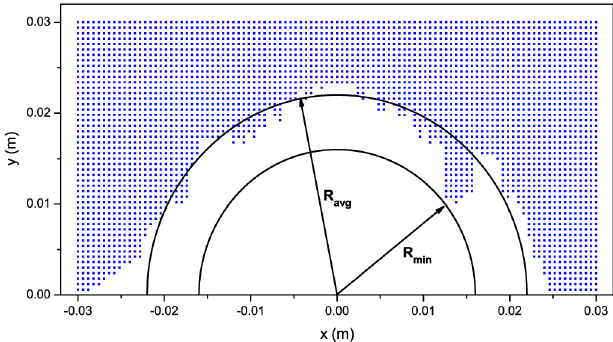
FIG. 3. The quantitative standard of dynamic aperture. R the minimum radius, and R